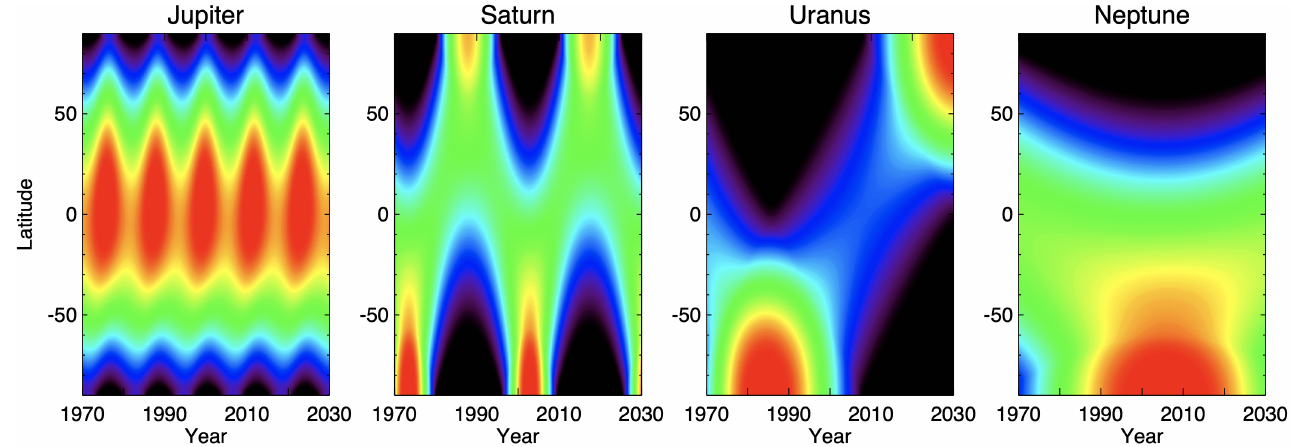
Figure 15. Normalized solar insolation patterns from 1970 to 2030, neglecting ring shadows. The solar insolation pattern is governed by its orbital elements (period, inclination, eccentricity), as well as axial tilt, as shown in Table 3; black indicates no illumination. Jupiter, the only giant planet with little tilt, experiences only slight differences between the northern and southern hemispheres and receives ample equatorial insolation. Saturn has higher insolation at the south pole than at the north pole at their respective solstices, and ring shadows further block the winter hemisphere. Uranus was first observed near southern summer solstice and has not yet reached northern summer solstice; large portions of the planet receive no illumination for decades. Neptune has only been observed with southern illumination, due to its long orbital